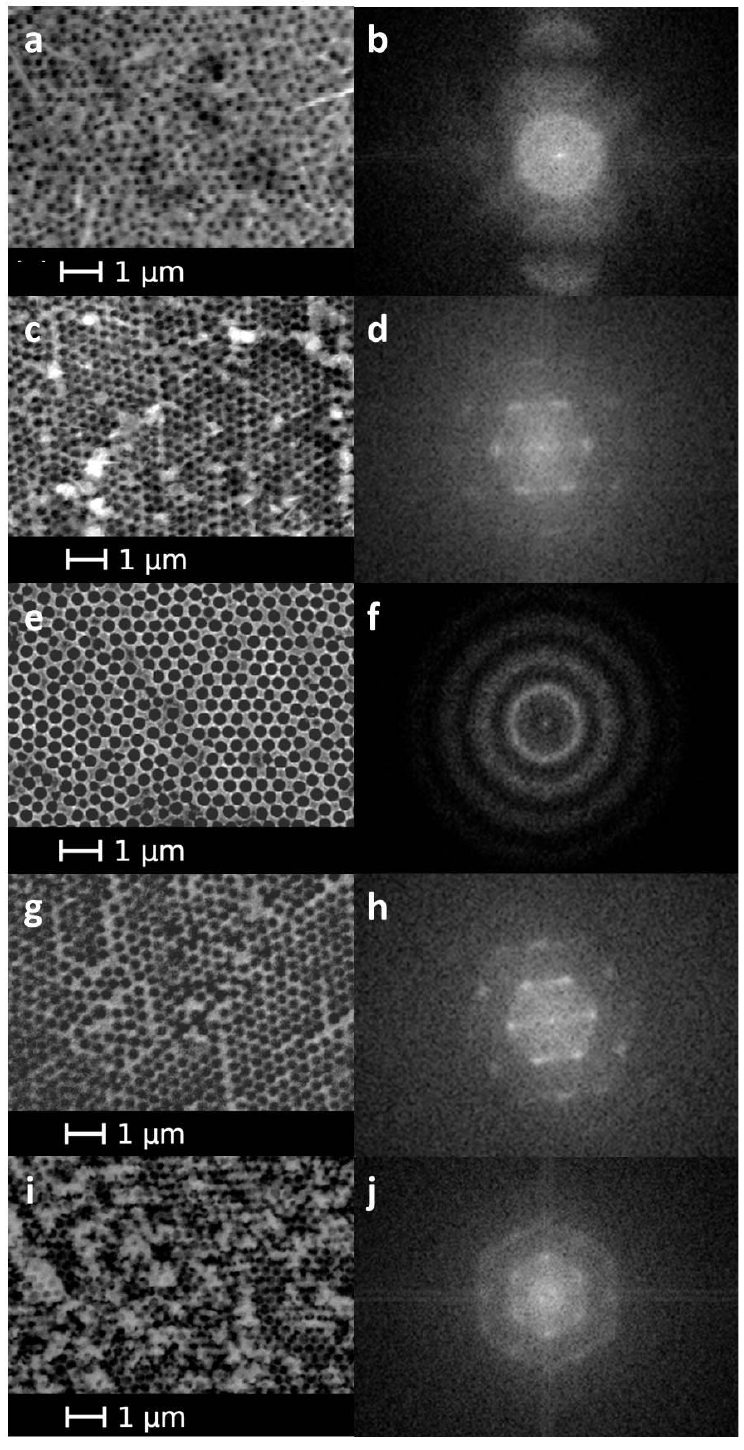
Figure 4. Micrographs of the Ag inverse opals with their Fourier images: ( a , b ) Ag-1, ( c , d ) Ag-2, ( e , f ) Ag-3, ( g , h ) Ag-4, ( i , j ) Ag-5.